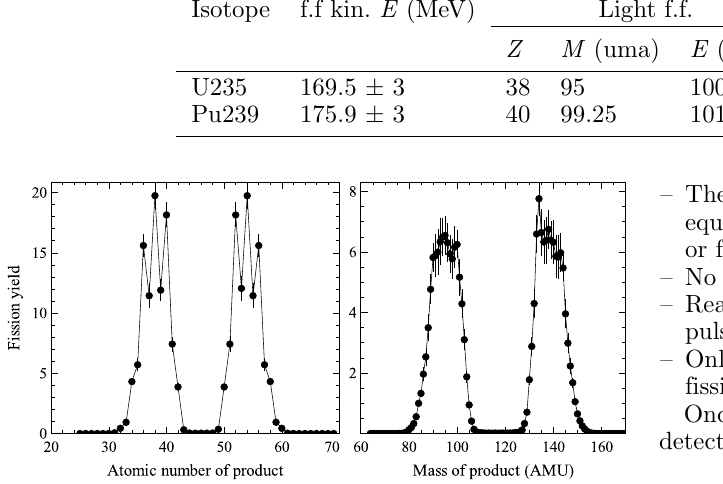
Fig. 4. Thermal neutron fission yield of uranium 235 from the JEFF 3.1.1